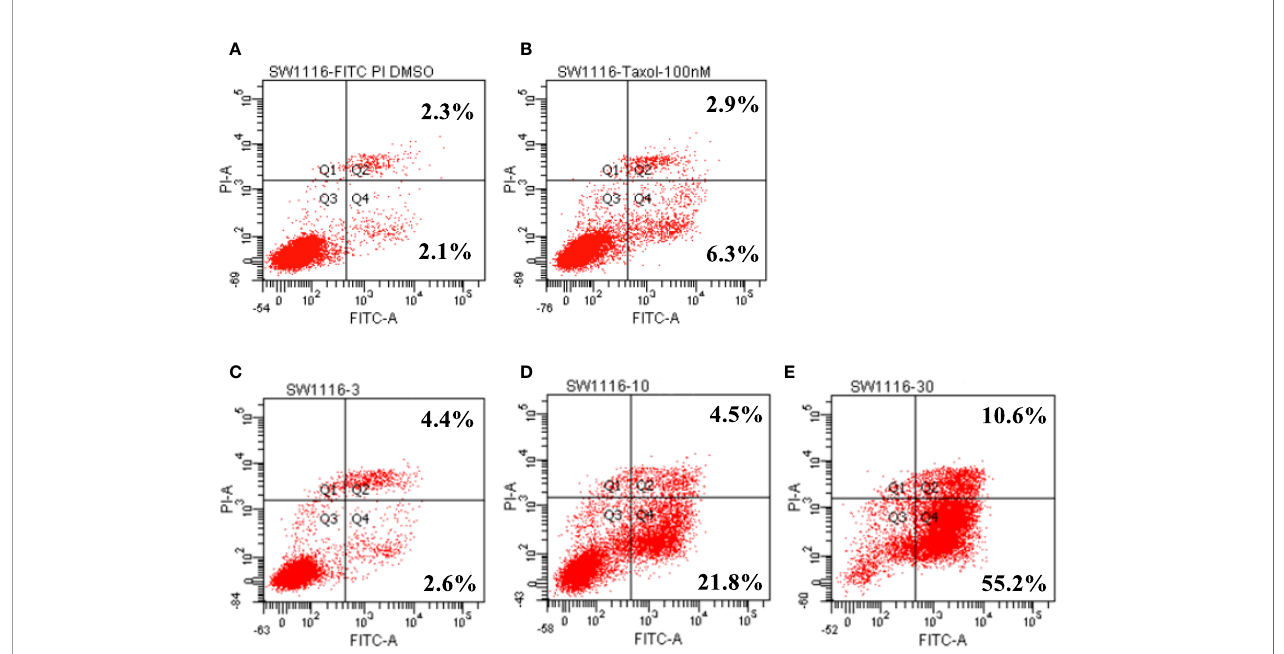
FIGURE 5 | Leiocarpin E-7 ′ -monoacetate induced early apoptosis. The annexin V fl uorescein isothiocyanate (FITC)/propidium iodide (PI) staining assay was analyzed by fl ow cytometry. SW 1116 cells were cultured with chemicals for 36 h: (A) vehicle; (B) Taxol (100 nM); (C) leiocarpin E-7 ′ -monoacetate (3 m M); (D) leiocarpin E-7 ′ -monoacetate (10 m M); (E) leiocarpin E-7 ′ -monoacetate (30 m M).